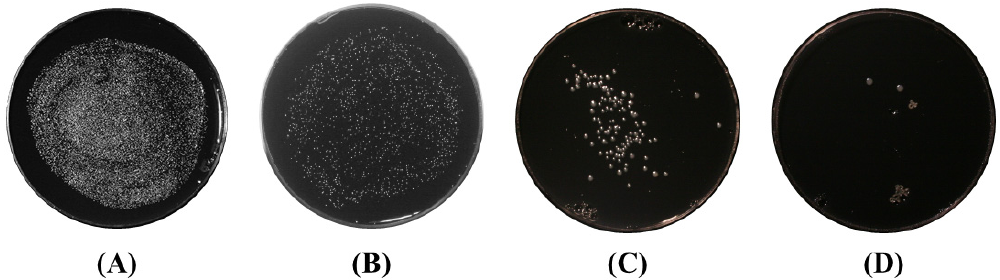
Figure 6. Time-dependent inhibition of XfDD growth by plasma exposure of cells discharged 1 day after plating. Photos were taken after 15 days post-exposure. The figure reports typical results for cells untreated ( A ) and treated for 10 ( B ), 100 ( C ), and 200 ( D ) s. concentration of 10 7 CFU mL − 1 (Figure 7), decimal dilutions from 10 5 to 10 3 CFU mL − 1 of XfDD inoculum were applied to the BCYE agar plates in subsequent experiments